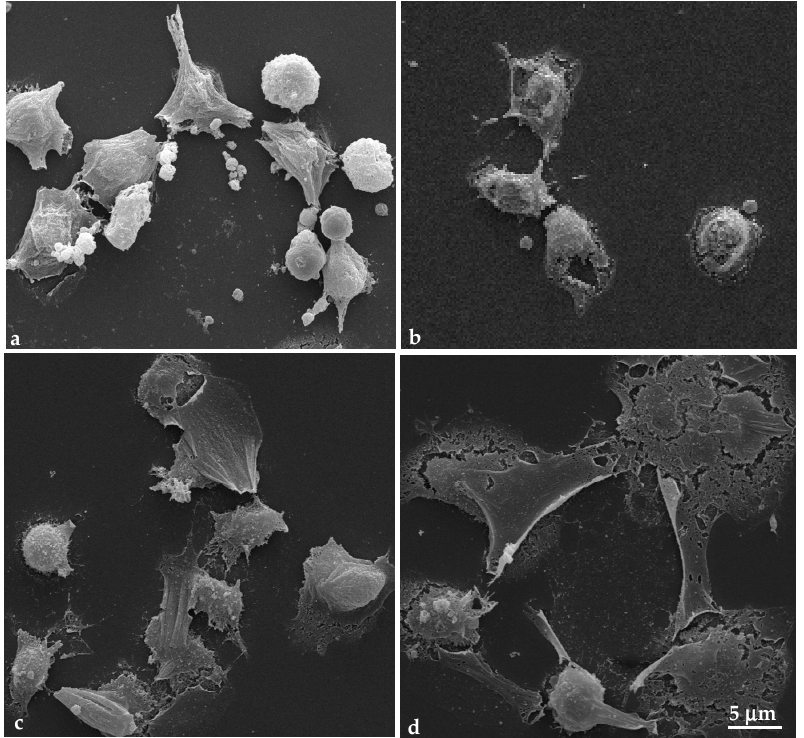
Figure 7. SEM micrographs of SKBR3 cells after 24 h of V. macrophylla EO incubation (0.01 ( a ), 0.1 ( b ), 1.25 ( c ) and 2.5 ( d ) µ g/mL, respectively ).